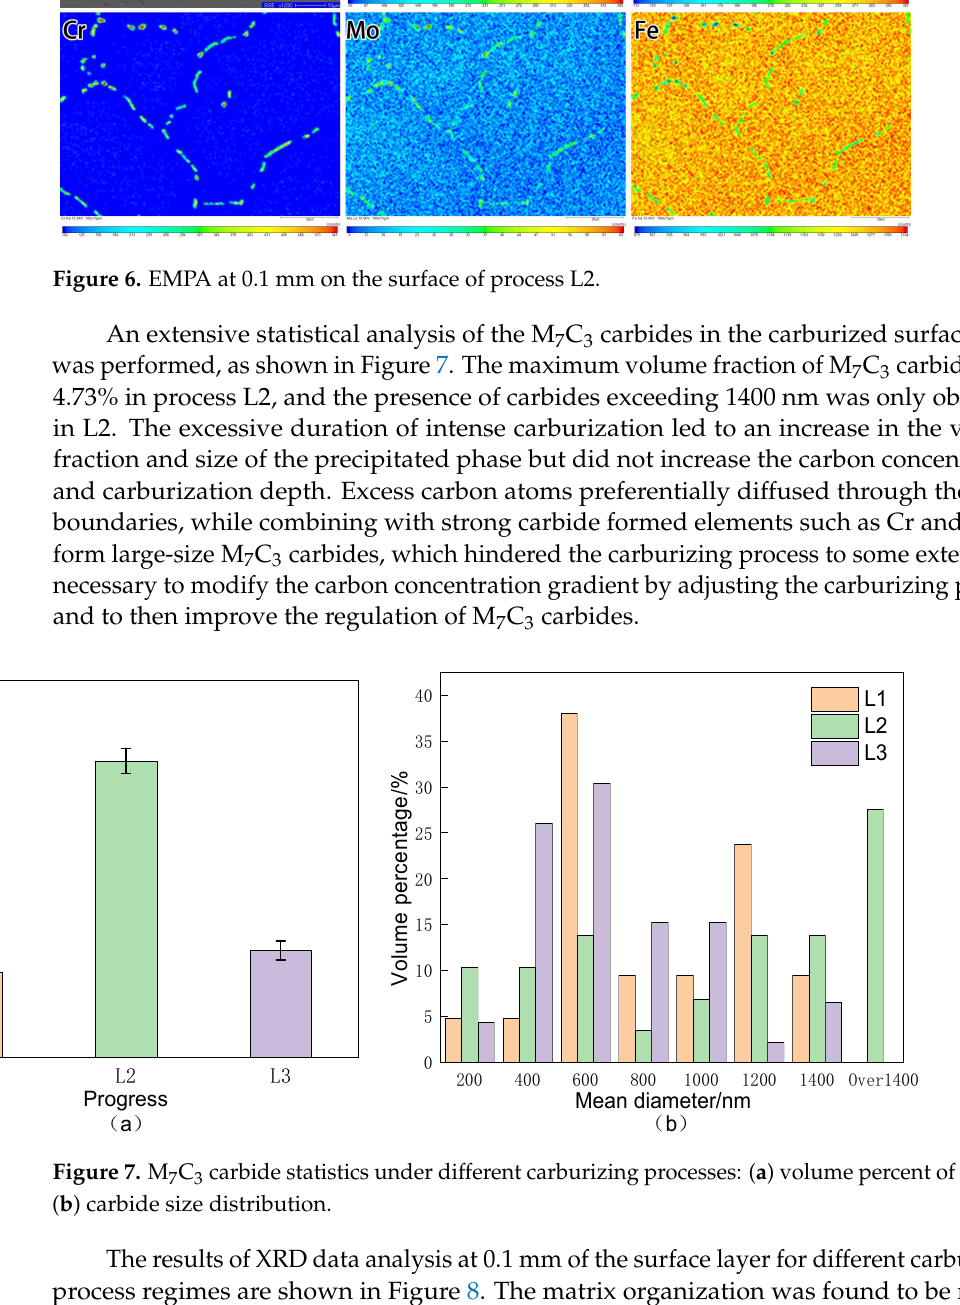
Figure 5. SEM of surface layer 0.1 mm: ( a ) process L1; ( b ) process L2; ( c ) process L3.